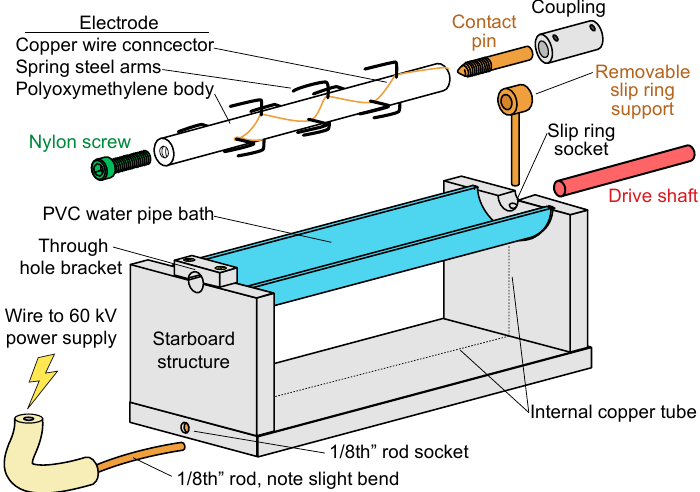
Figure 4. A semi-exploded view of an electrode and the electrode bath. A photograph of this part is pictured in Figure A4. To assemble, the contact pin is screwed into the electrode and pushed into the removable slip ring support . The removable slip ring support is pushed into its socket, which guides the electrode and contact pin into the PVC water pipe bath. The nylon screw is passed through the through hole bracket and screwed into the electrode. The coupling can then attach the contact pin and driveshaft together. The 1/8” rod is then plugged in.